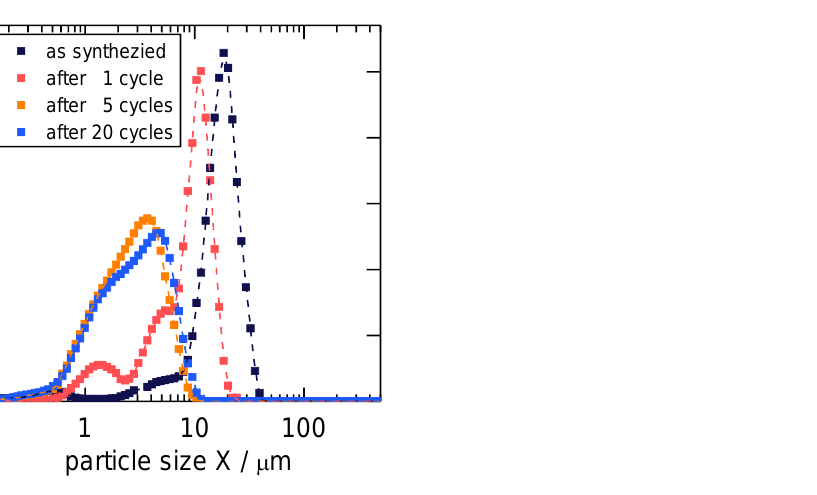
Figure 3. Particle size distribution for 1 after different numbers of adsorption-desorption cycles plotted as the derivative dN / dX.